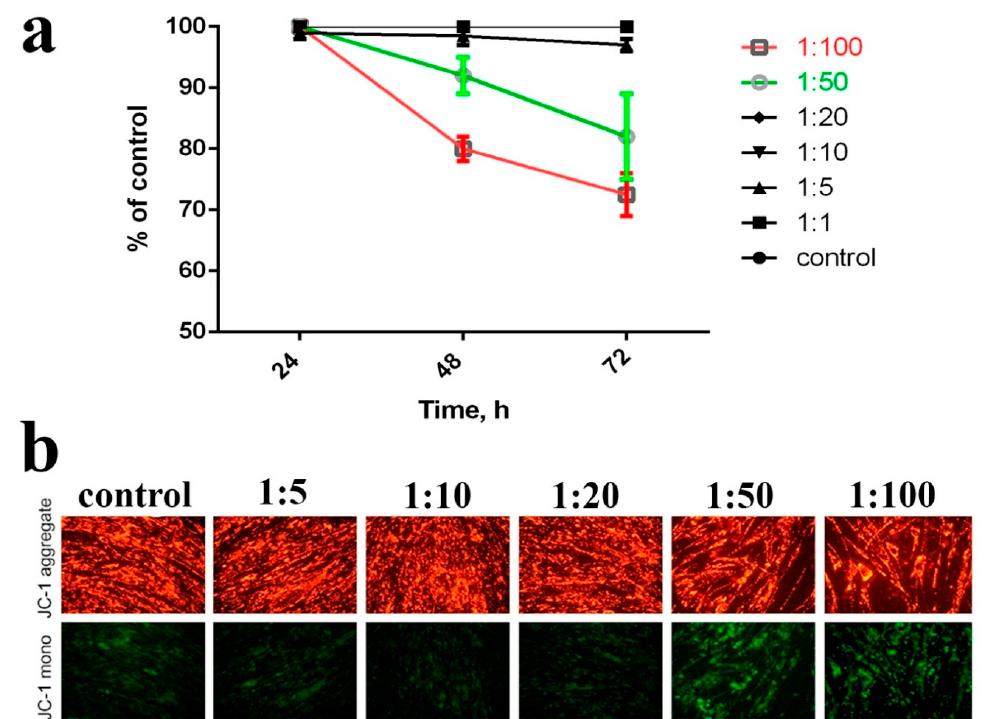
Figure 6. The effect of nanoceria-loaded polyelectrolyte microcapsules on the mitochondrial membrane potential (MMP) in hMSC after 24, 48, and 72 h of incubation ( a ). Micrographs of hMSC with JC-1 dye after incubation (24 h)with nanoceria-loaded polyelectrolyte microcapsules ( b ). Cells were plated in 96-well plates and left overnight. Then, nanoceria-loaded polyelectrolyte microcapsules were added, and after 24, 48, and 72 h, cells were stained with JC-1 dye. Control: without the addition of microcapsules.